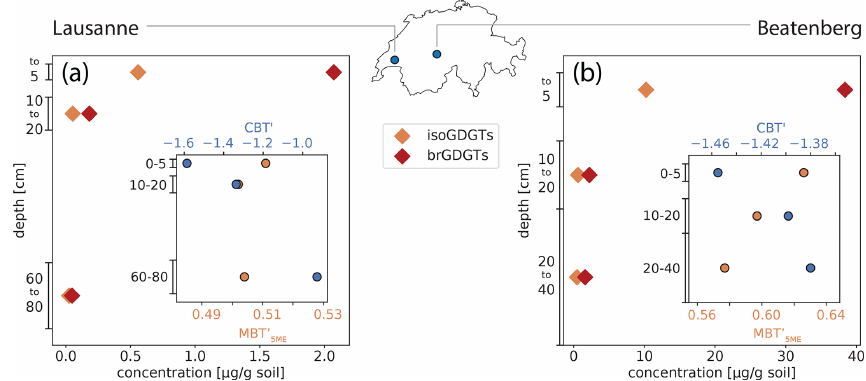
Figure 3. Branched GDGT (brGDGT) abundances and parameter ratios in Lausanne and Beatenberg soil profiles. In both soils ( a – Lausanne; b – Beatenberg), the concentration of the samples per dry weight decreases rapidly with depth. The inner plots show the brGDGT-derived MBT (cid:48) (orange) and the CBT (cid:48) (blue) indices in the respective soil. While the MBT (cid:48) 5ME significantly with depth in the Lausanne